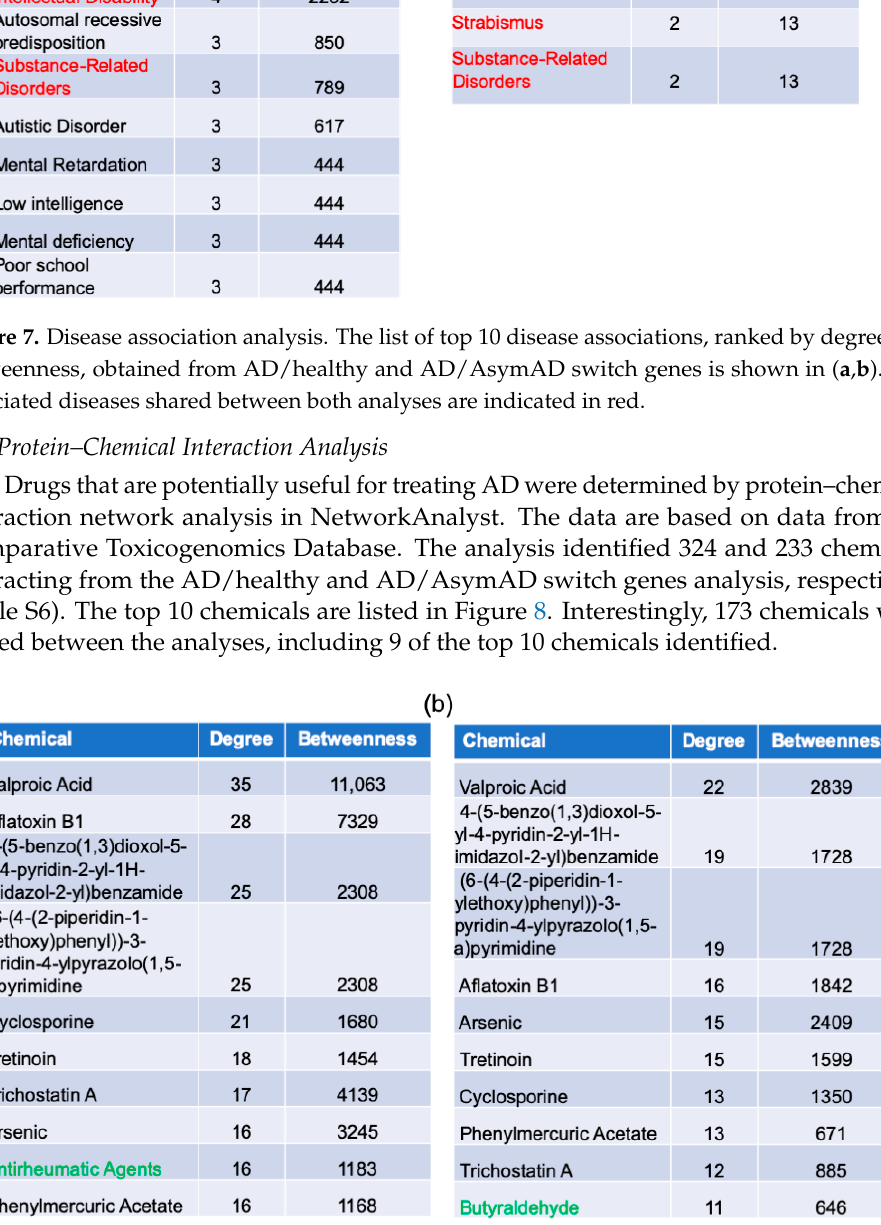
Figure 8. Protein–chemical interaction analysis. NetworkAnalyst was used to identify potential therapeutic reagents. The top 10 chemicals identified from the AD/healthy and AD/AsymAD switch genes are shown in ( a , b ), respectively. The chemicals shown in green are unique for each